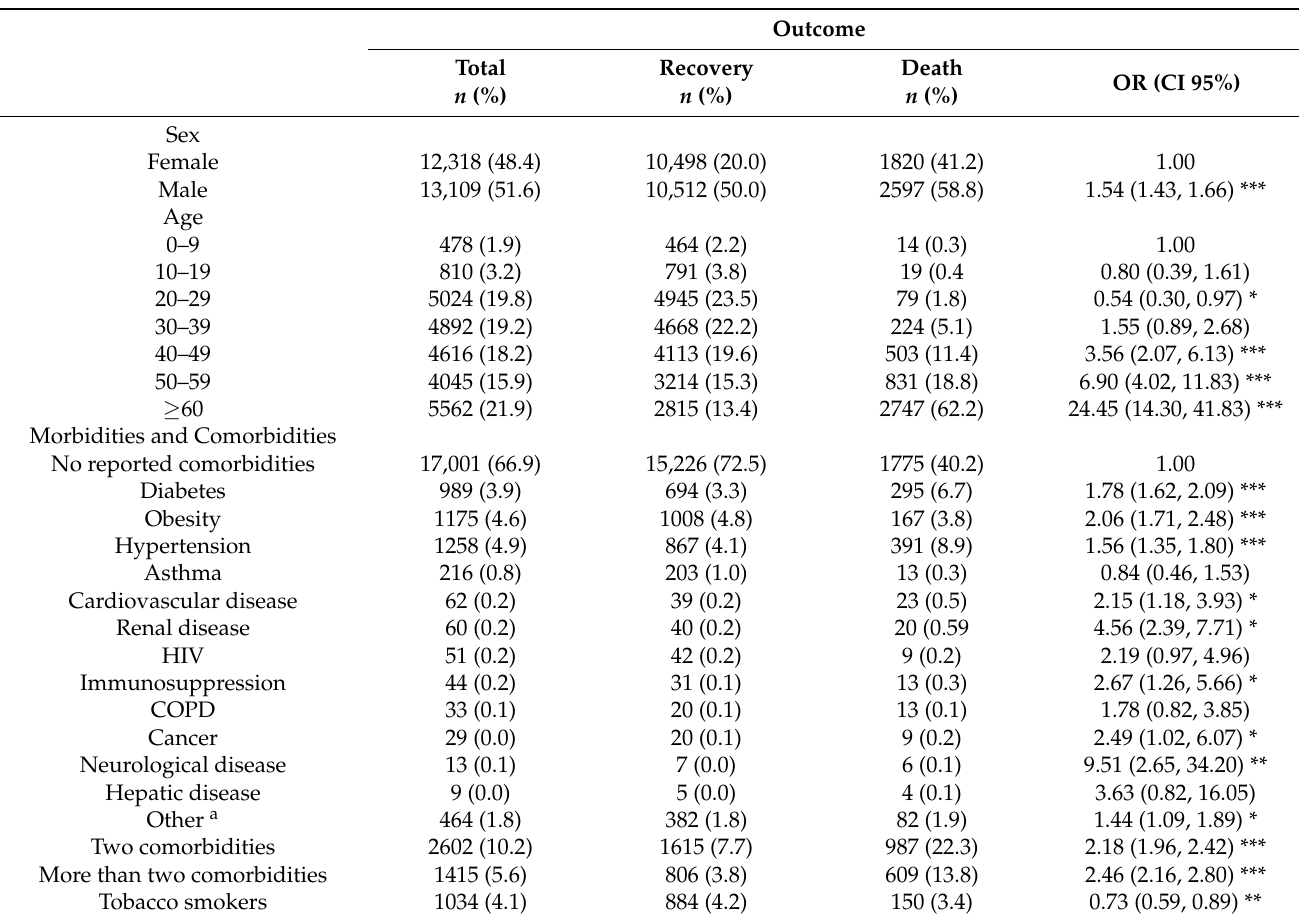
Table 4. Multivariate ordinal regression analyses of factors associated with COVID-19 outcome ( n = 25,427).